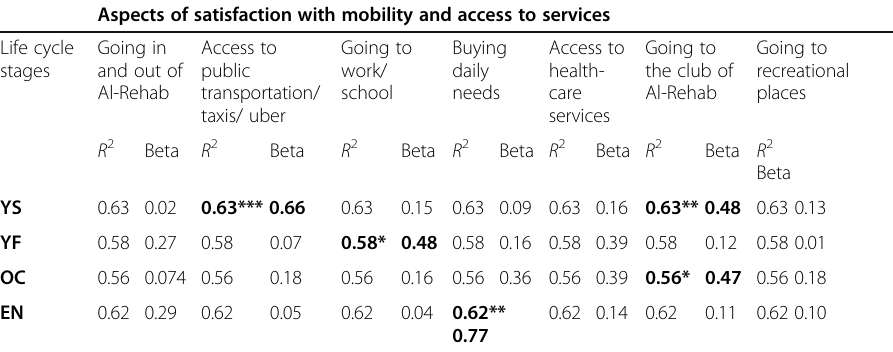
Table 12 Regression analysis results of satisfaction with mobility and access to services Aspects of satisfaction with mobility and access to